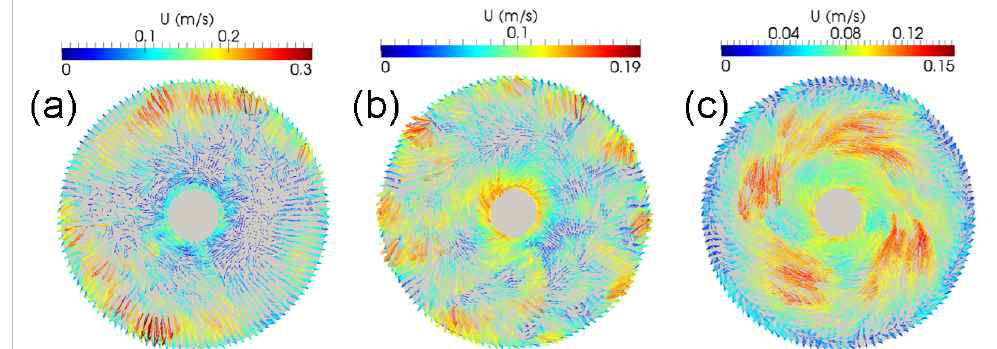
Figure 7. Flow velocity vectors in the upper plane of the melt under the influence of RMF for ( a ) Case 4; ( b ) Case 5; and ( c ) Case 6.